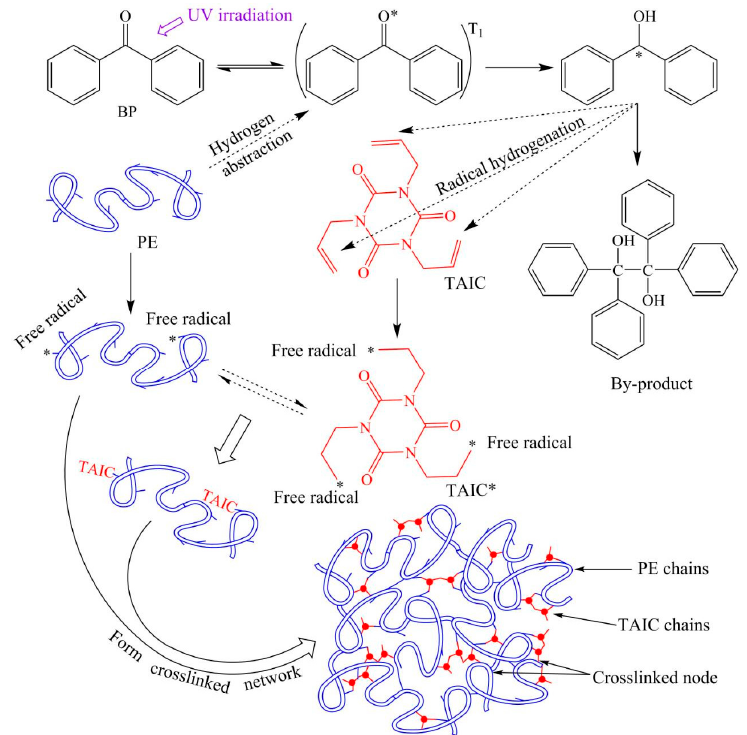
Figure 1. Schematic crosslinking reaction of polyethylene initiated by UV irradiation.